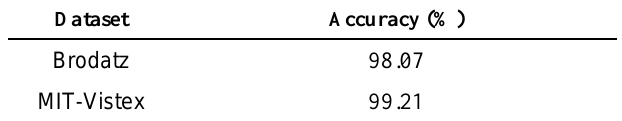
Table 6. Accuracy of the proposed system